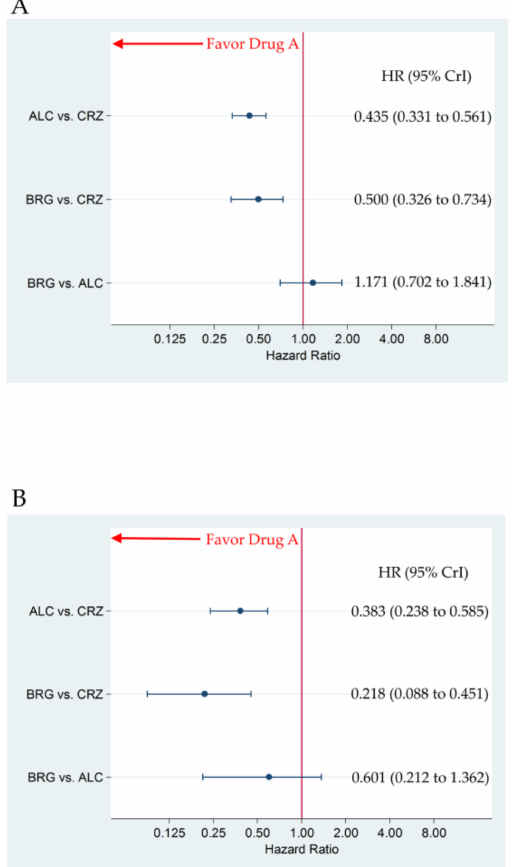
Figure 3. The comparative e ffi cacy, in terms of progression-free survival, of brigatinib 180 mg once daily (7-day run-in period of 90 mg once daily) and alectinib 300 / 600 mg twice daily. The comparisons are expressed as drug A versus drug B. Data are expressed in terms of hazard ratio (HR) and 95% credible intervals (CrIs). ( A ) Comparison in all participants; ( B ) Comparison in the patient group with central nervous system metastasis. ALC, alectinib; CRZ, crizotinib; BRG,